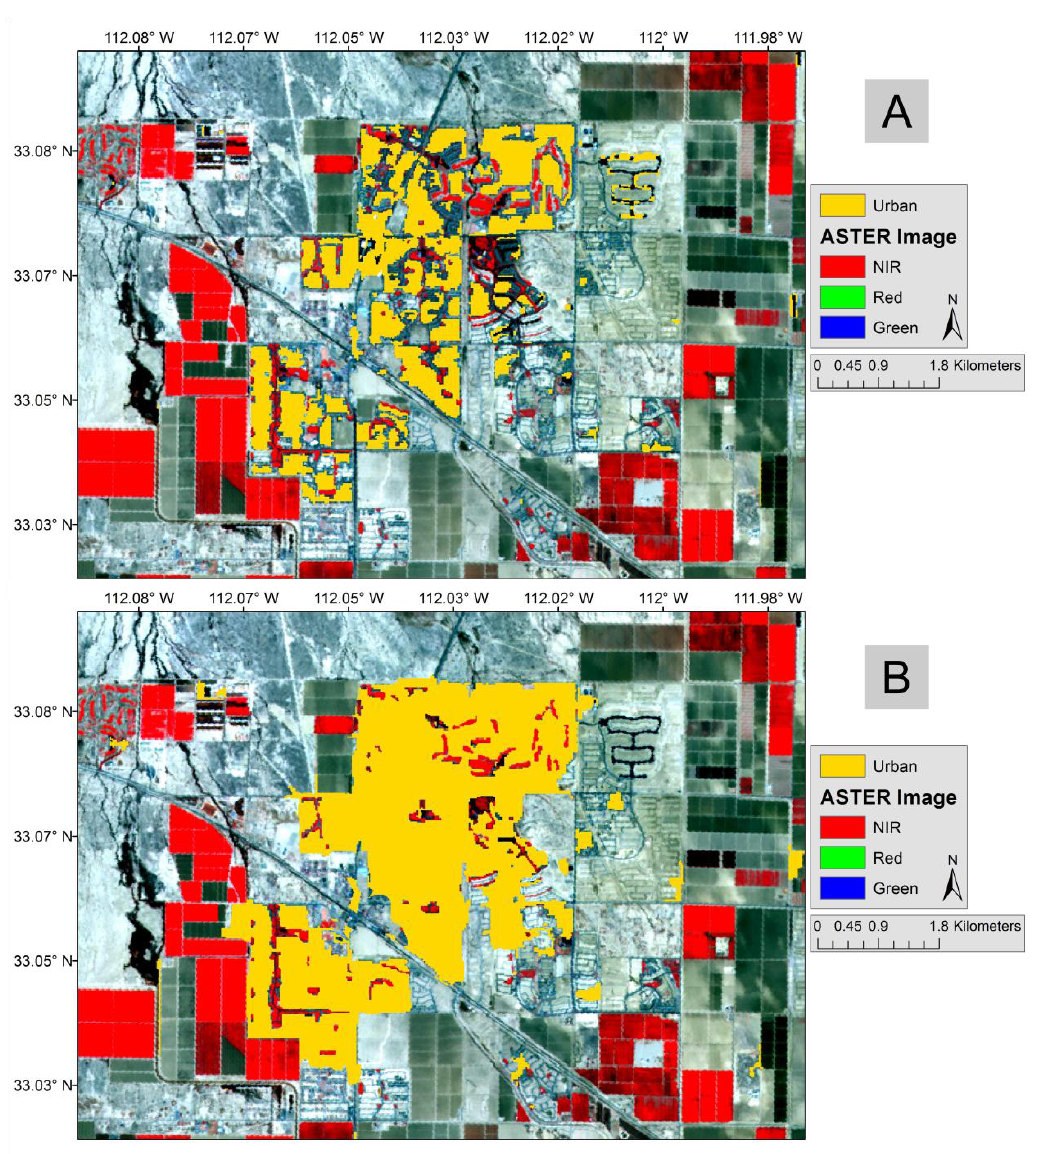
Figure 7. ( A ) Initial classification of urban land-use. ( B ) Intermediary urban land-use after “grow region” and merging of